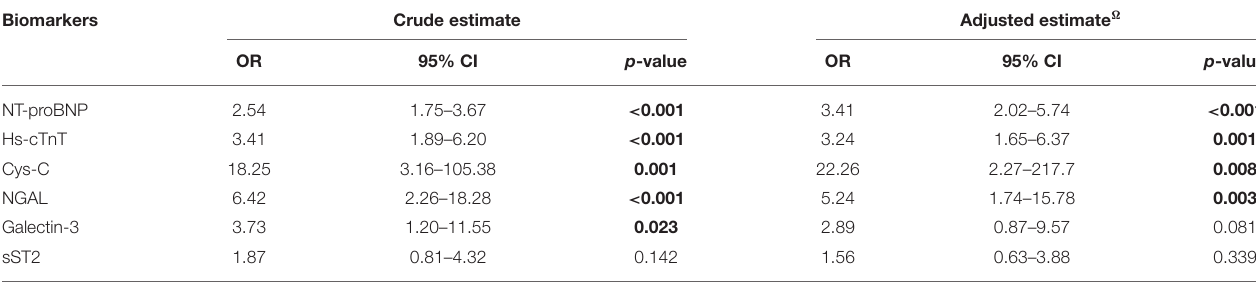
TABLE 3 | Association between biomarker levels and diastolic dysfunction diagnosis in patients with chronic Chagas cardiomyopathy. Biomarkers